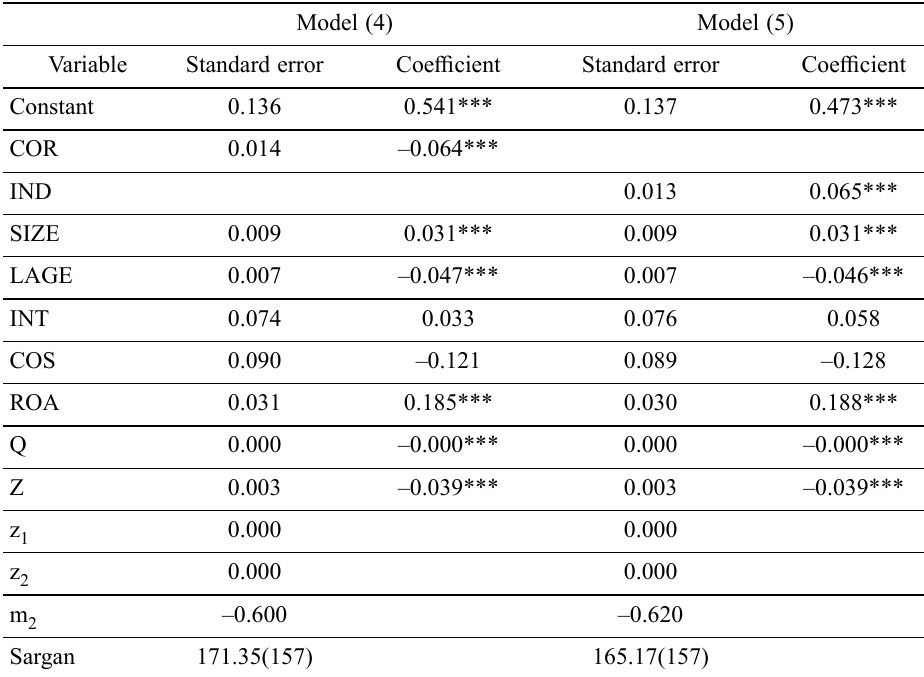
Table 4. GMM Panel Data Regression relative to the influence of type of main